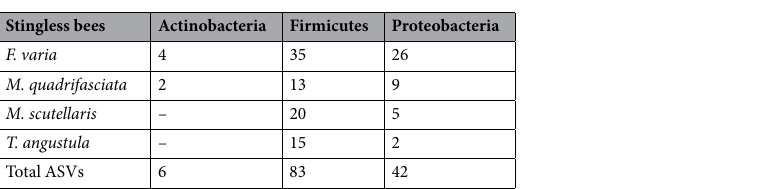
Table 2. Abundance of bacterial phyla observed in F. varia , M. quadrifasciata , M. scutellaris , and T. angustula larval